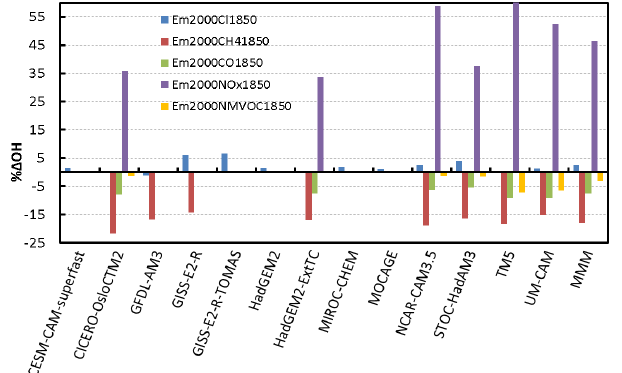
Figure 5. Percent tropospheric mean OH concentration change due to preindustrial to present day changes in climate (Em2000Cl1850), methane burden (Em2000CH41850), and anthropogenic emissions of CO (Em2000CO1850), NO x , (Em2000NOx1850), and NMVOCs (Em2000NMVOC1850). The multi-model mean (MMM) OH changes for each experiment are also shown.